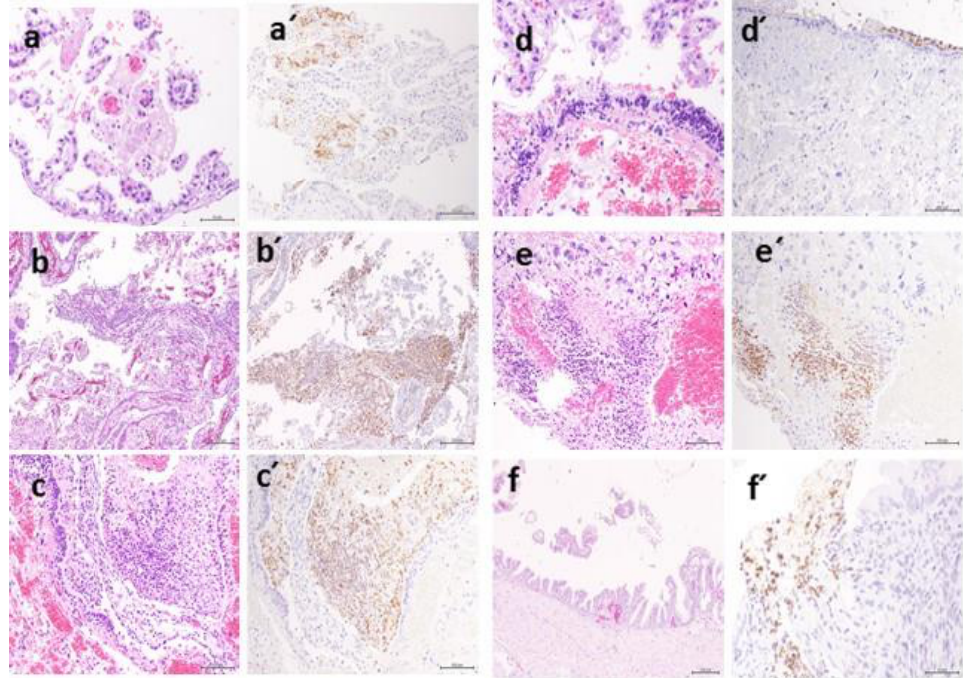
Figure 8. Multifocal necrosis in chorionic villi ( a ), spongiotrophoblast areas which anchor the placenta into the uterine lining ( b , c ), Hyalinization of the Reichert’s membrane associated with necrosis and inflammatory cell infiltration ( d ) and focal necrosis around maternal blood spaces rich with mononuclear cells ( e ) and cervical epithelium necrosis ( f ). ( a’ – f’ ): Immunohistochemistry revealed positive staining of the a ff ected tissue referred to as dashed letters corresponding to images stained with